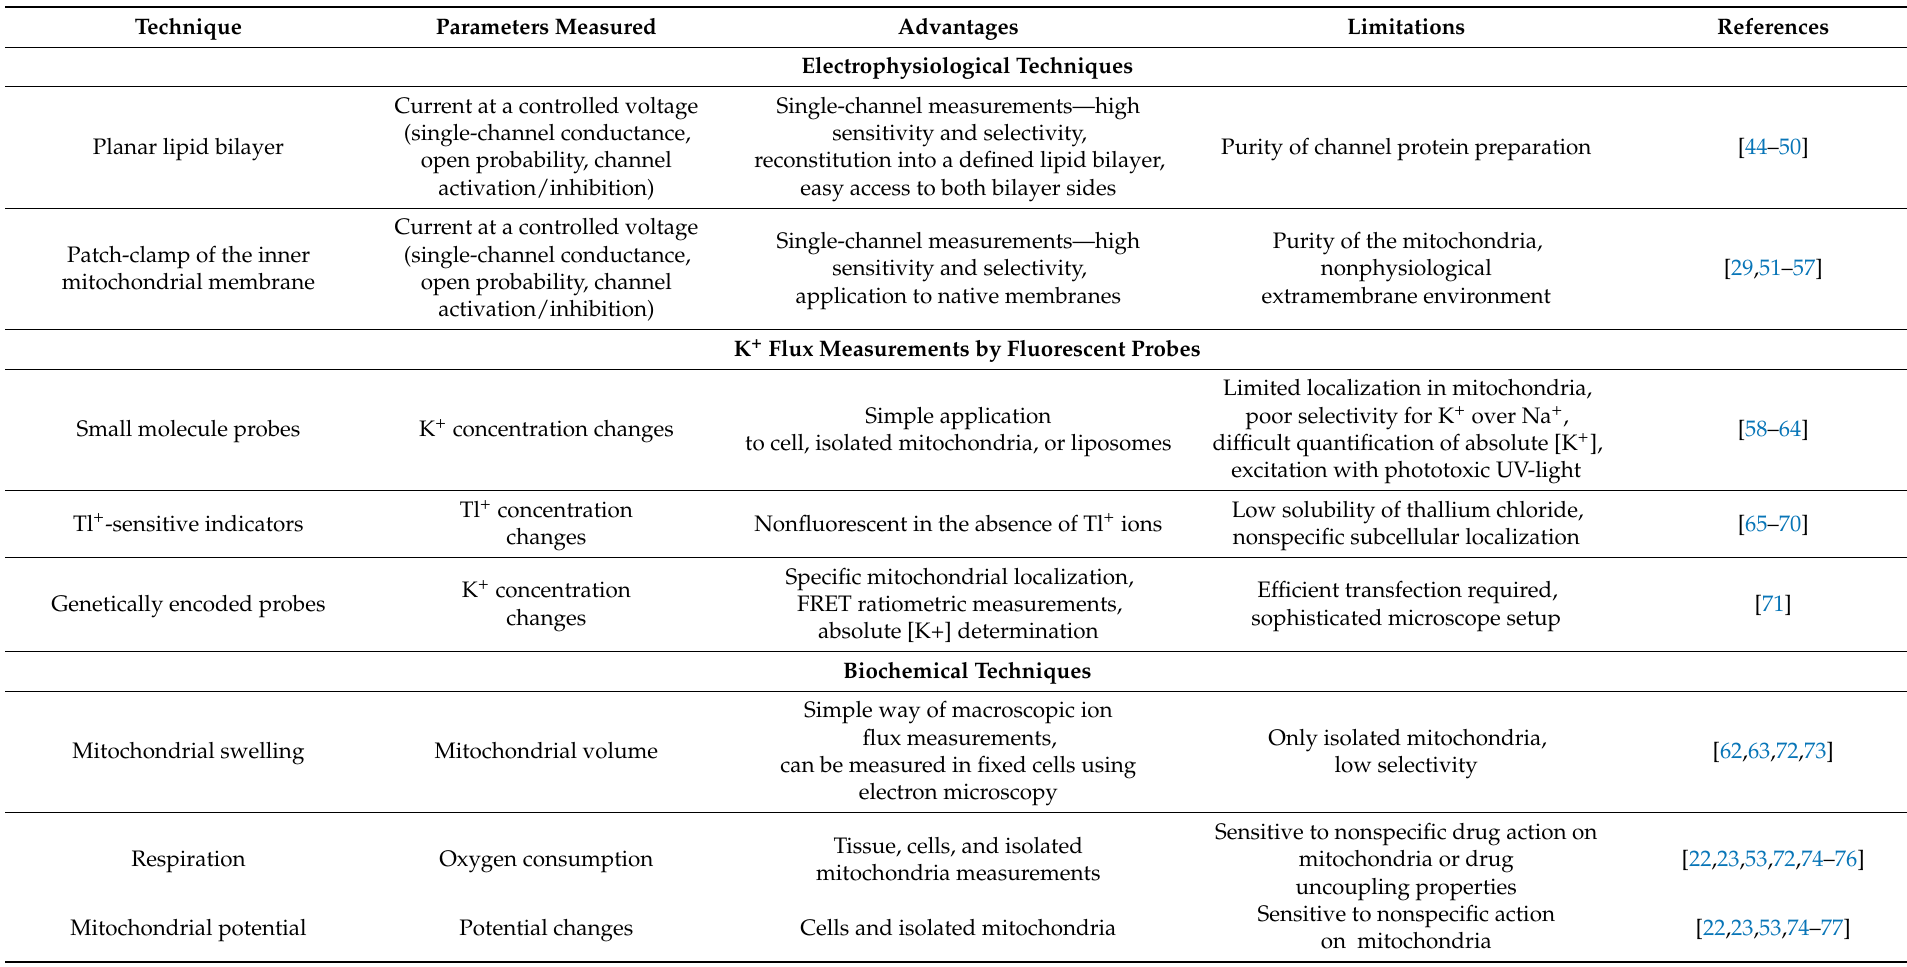
Table 1. Overview of methods applied to study mitochondrial potassium